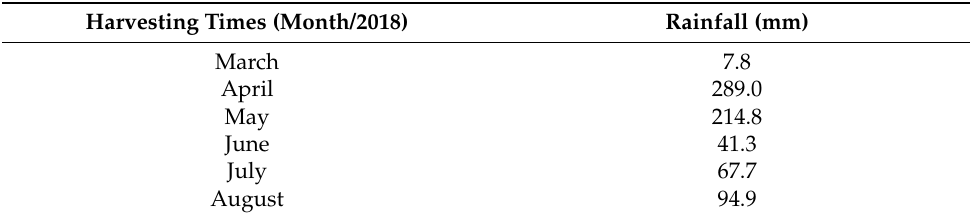
Table 1. Statistics of rainfall at meteorology station (M.38C) in Sikhio district, Nakhon Ratchasima province,